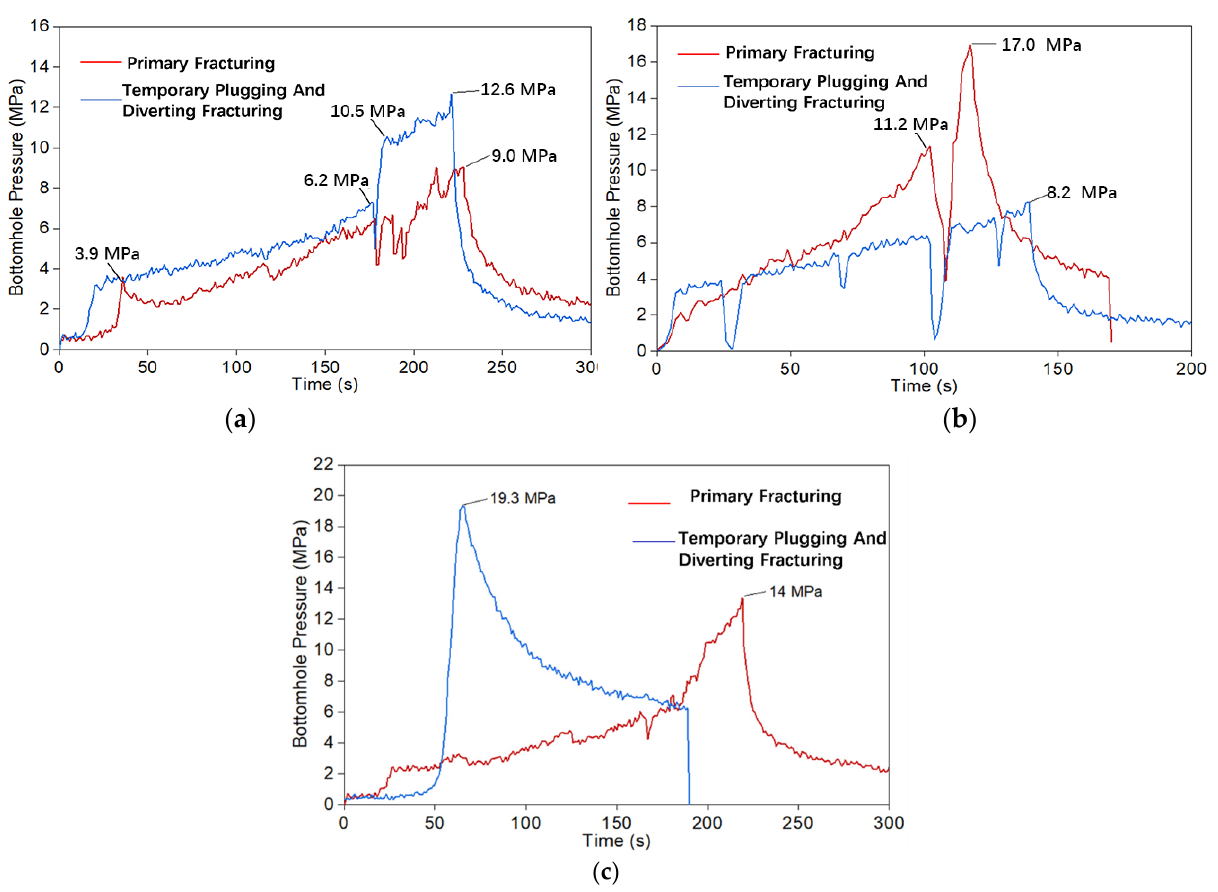
Figure 6. Pressure curves for coal samples 1#–3#: ( a ) pressure curves of sample 1#; ( b ) pressure curves of sample 2#; ( c ) pressure curves of sample 3#.